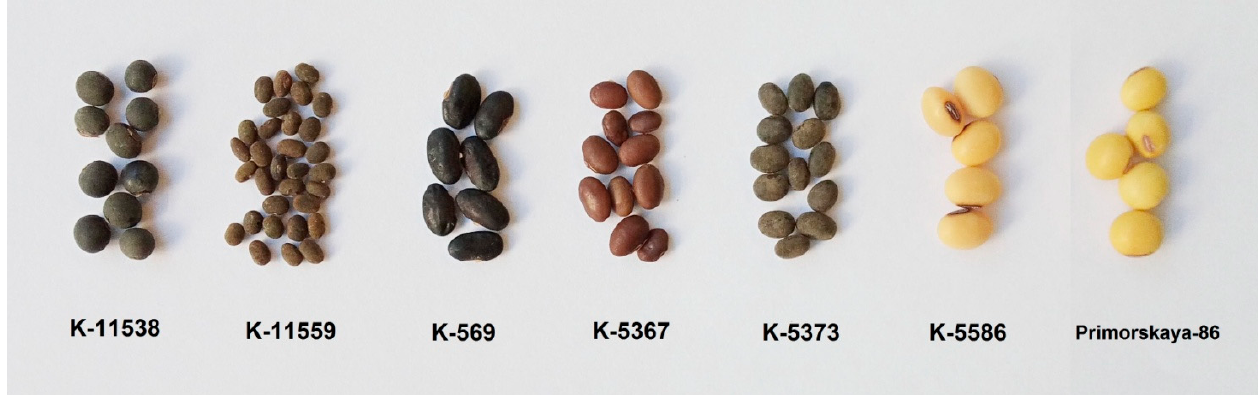
Figure 1. Soybean varieties k-11538 (Russia), k-11559 (Russia), k-569 (China), k-5367 (China), k-5373 (China), k-5586 (Sweden), and Primorskaya-86 (Russia).